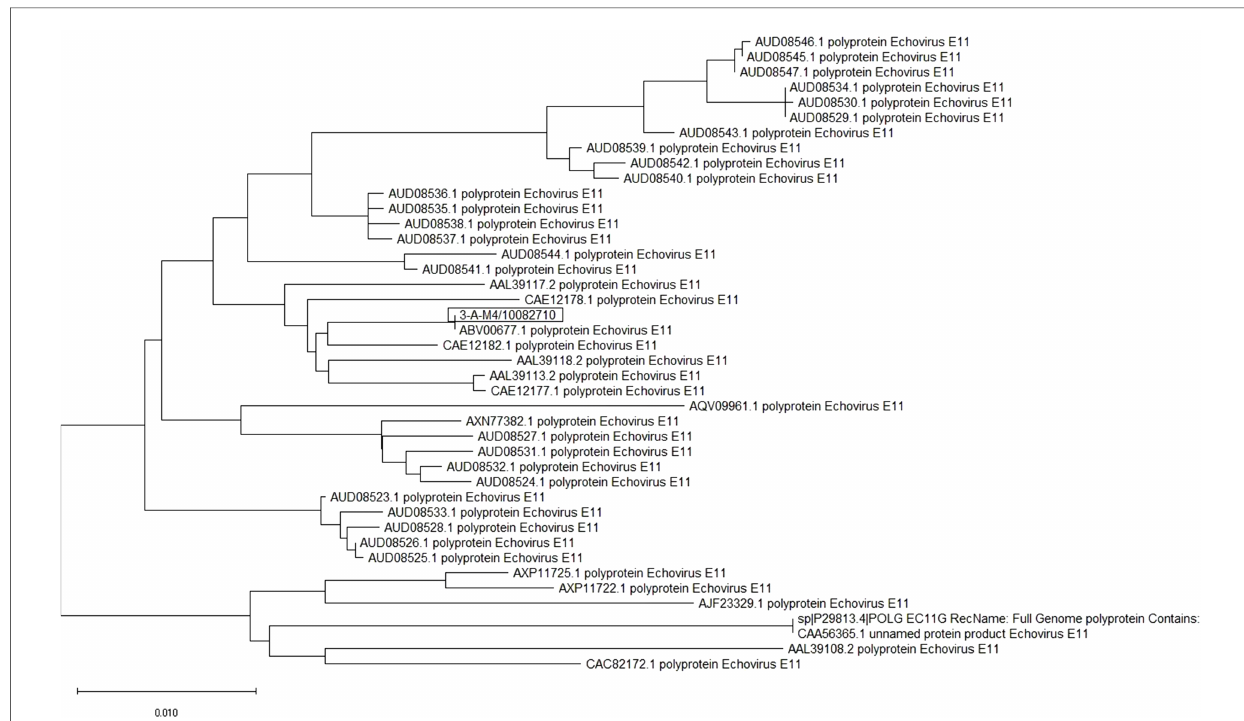
FIGURE 1 E-11 sequence information and phylogenetic analysis. Sequence of E-11 isolated from two patients in Guangzhou Women and Children ’ s Medical Center was shown. It revealed that GWCMC01/GZ/CHN/2019 is 99% consistent with E-11 strain D207 (GenBank No.